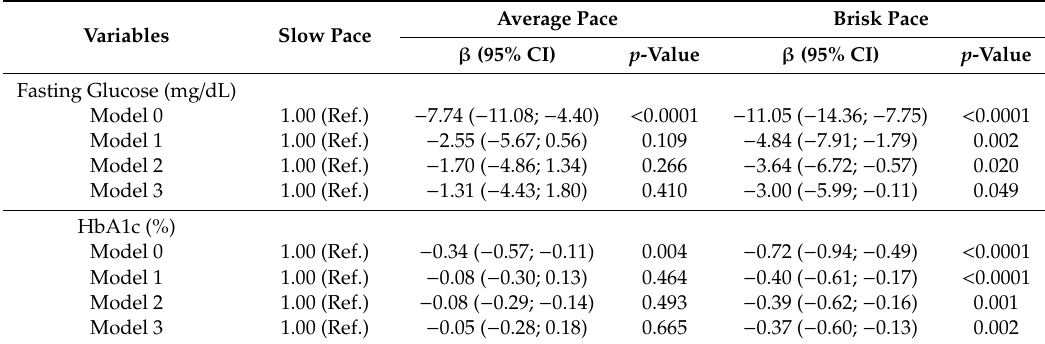
Table 2. Association of walking pace with fasting glucose and glycosylated haemoglobin A (HbA1c).